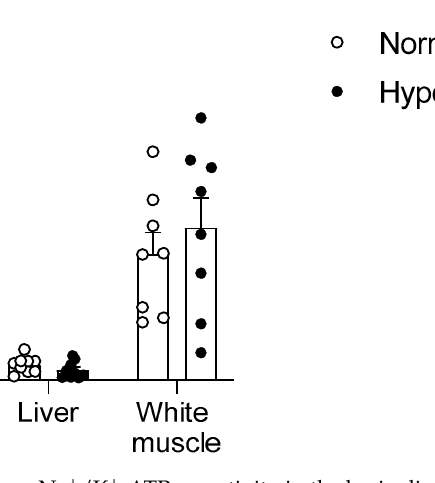
Figure 6. Effects of chronic hypoxia on Na + /K + -ATPase activity in the brain, liver, and white muscle of normoxic controls ( N = 10) and hypoxia-acclimated goldfish ( N = 10). Values are means ± s.e.m. Dots represent individual data points. Significant effect of hypoxia is indicated as HHH ( p < 0.001).